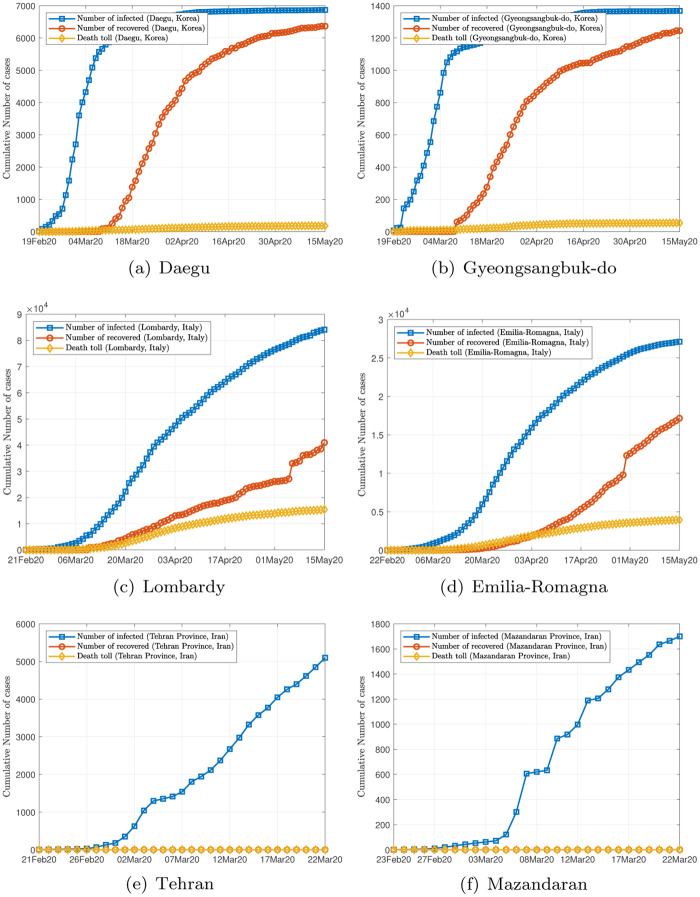
Samples of data.